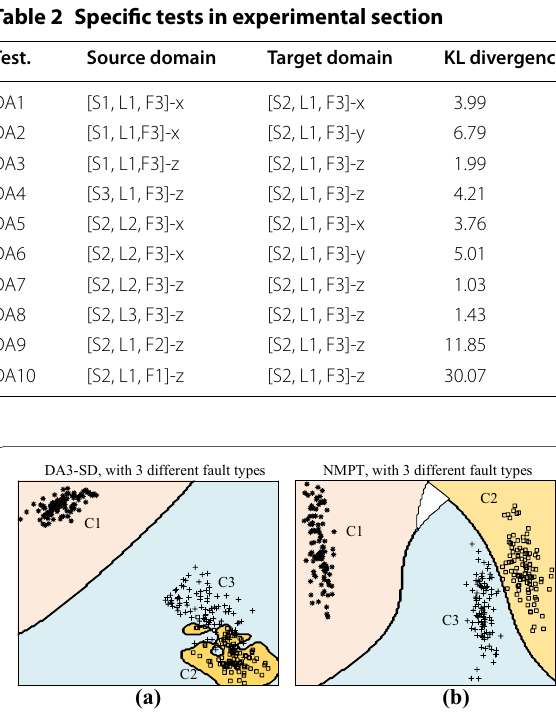
Figure 5 Classification hyperplane of DA3-SD: a Original DA3-SD; b